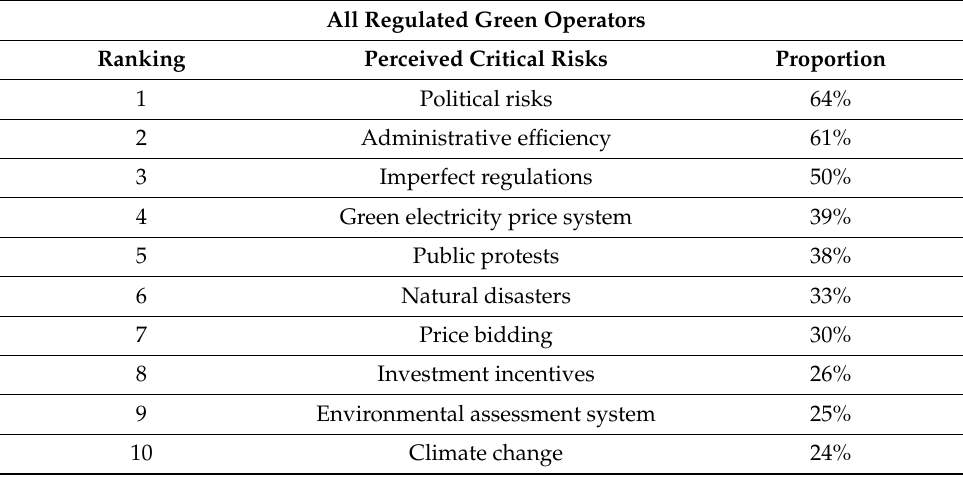
Table 5. The 10 most commonly recognized key risks for green energy businesses. All Regulated Green Operators